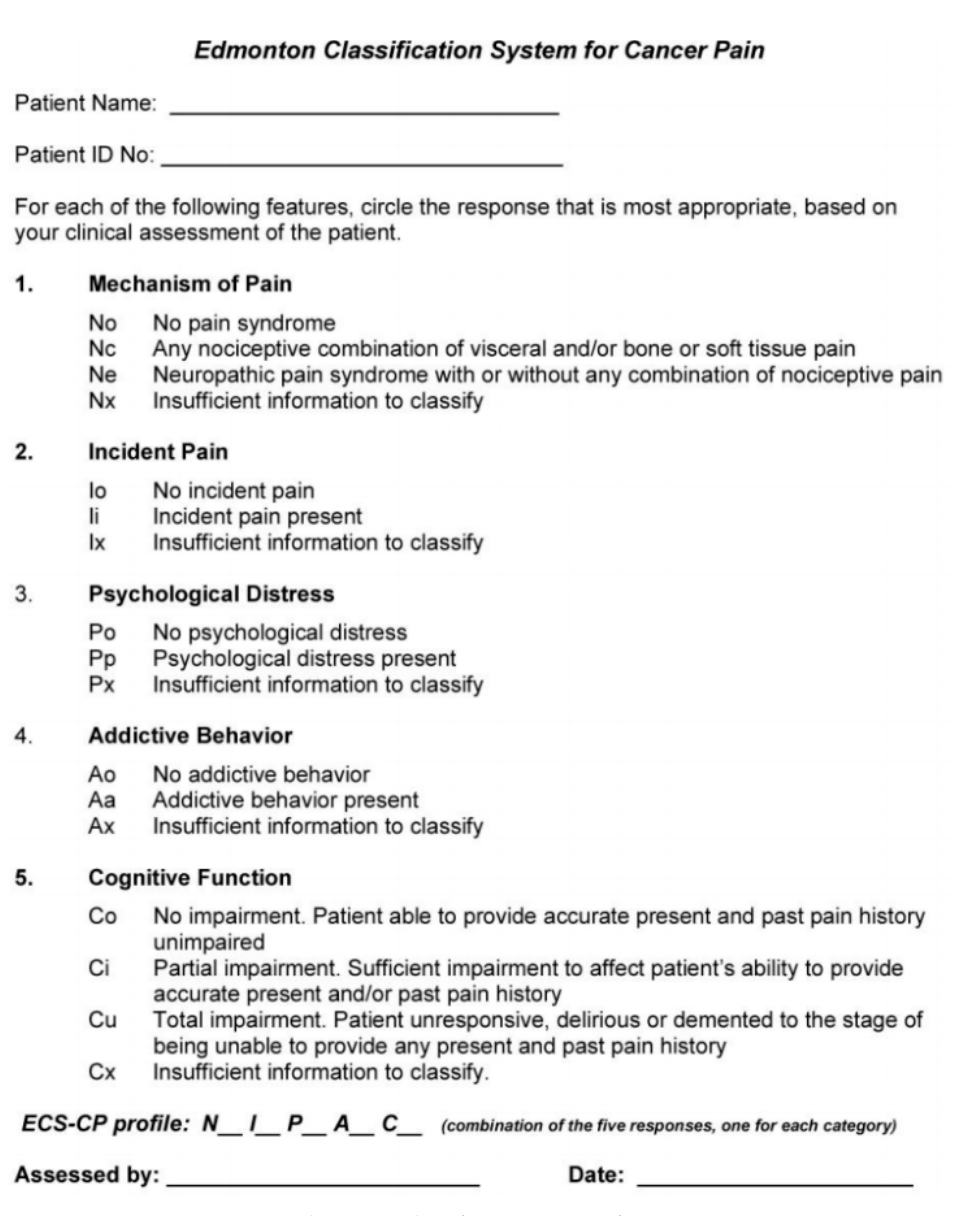
Figure 2. Edmonton Classification System for cancer pain.